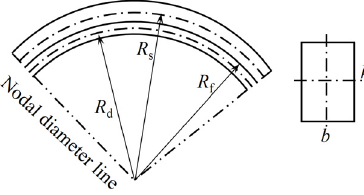
Figure 1. Split ring with rectangular cross ‐ section before and after installation.